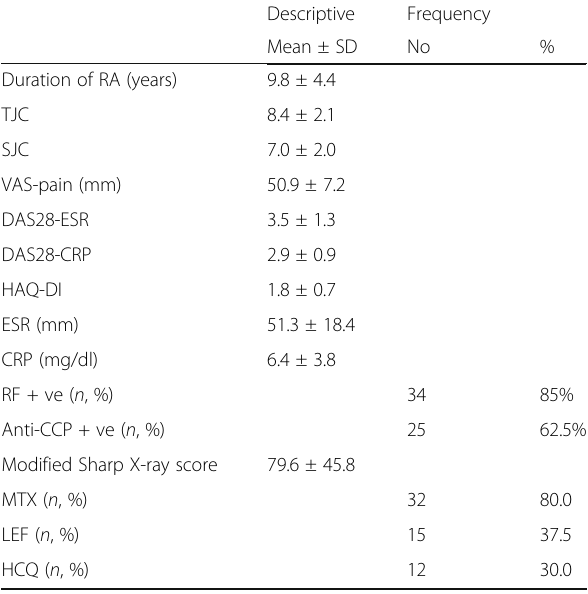
Table 2 The clinical, laboratory, radiographic, and treatment parameters of RA